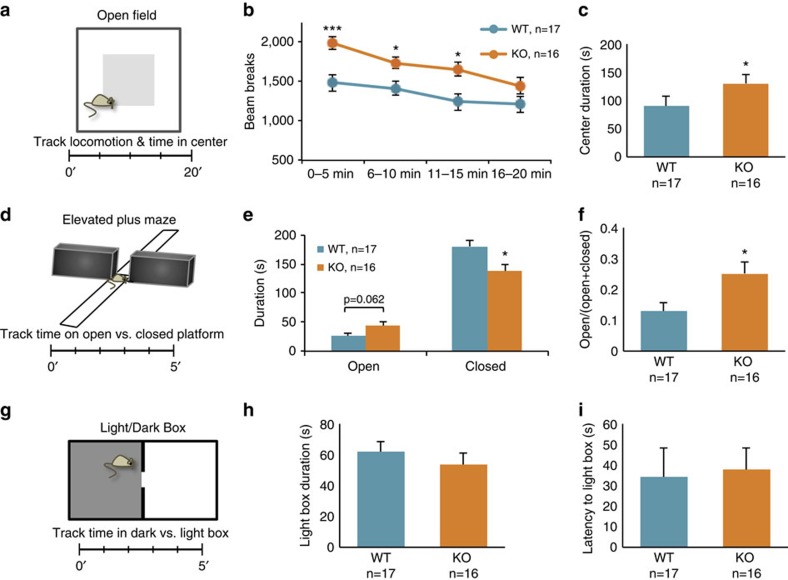
Loss of Phf8 confers resilience to anxiety.(a) Diagram of open field test. Mice are placed in an open, lit chamber and locomotion and time spent in the centre are monitored for 20 min. (b) Locomotion as quantified by sensor beam breaks within the open field chamber. (c) Time spent in the centre by Phf8 WT and KO mice. (d) Diagram of the elevated plus maze assay. Mice are placed in the centre of an elevated maze containing two open and two enclosed arms; time spent on each arm is monitored for 5 min. (e) Quantification of time spent by Phf8 WT and KO mice on each arm during the elevated plus maze assay. (f) Quantification of the fraction of time spent in the open arms over the total time for each genotype. (g) Scheme for light/dark box assay. Mice are placed in a container containing an enclosed ‘dark' half and an open ‘light' half. Time spent in either half is measured over a 5-min period. (h) Quantification of results from the Light/Dark box assay; the total time spent in the anxiogenic light box is shown. (i) Latency to first entry to the light box in the Light/Dark box assay is shown. Error bars=s.e.m. *=p<0.05, ***=p<0.001 (Student's t-test two-Tailed).